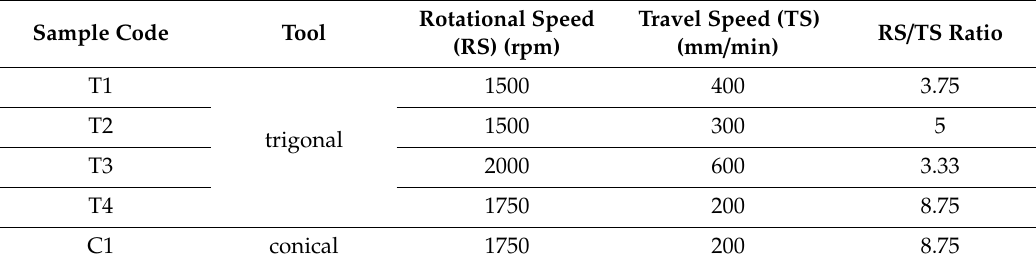
Table 2. Welding parameters used in the present